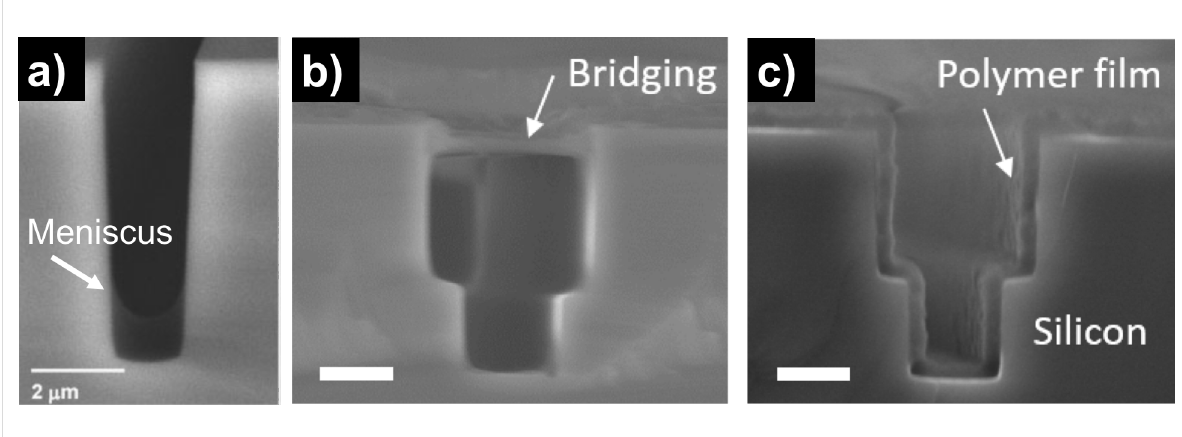
Figure 1: Micro-trenches with polymer coatings by a) solution with low substrat–interface energy, b) solution with high substrate–interface energy and c) iCVD (scale bar 2 µm). a) Reproduced with permission from [8], Copyright 2008 John Wiley and Sons. b),c) Reproduced with permission from [9], Copyright 2016 Massachusetts Institute of